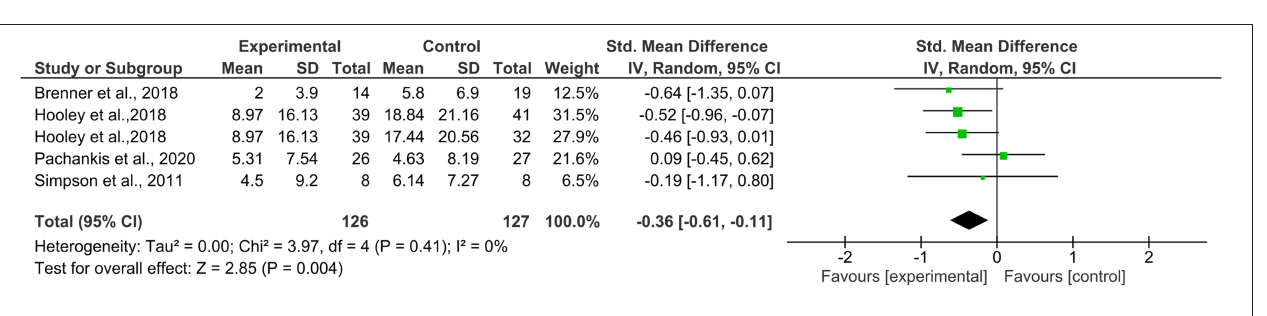
FIGURE 4 | Effects on suicidal ideation at 3-month